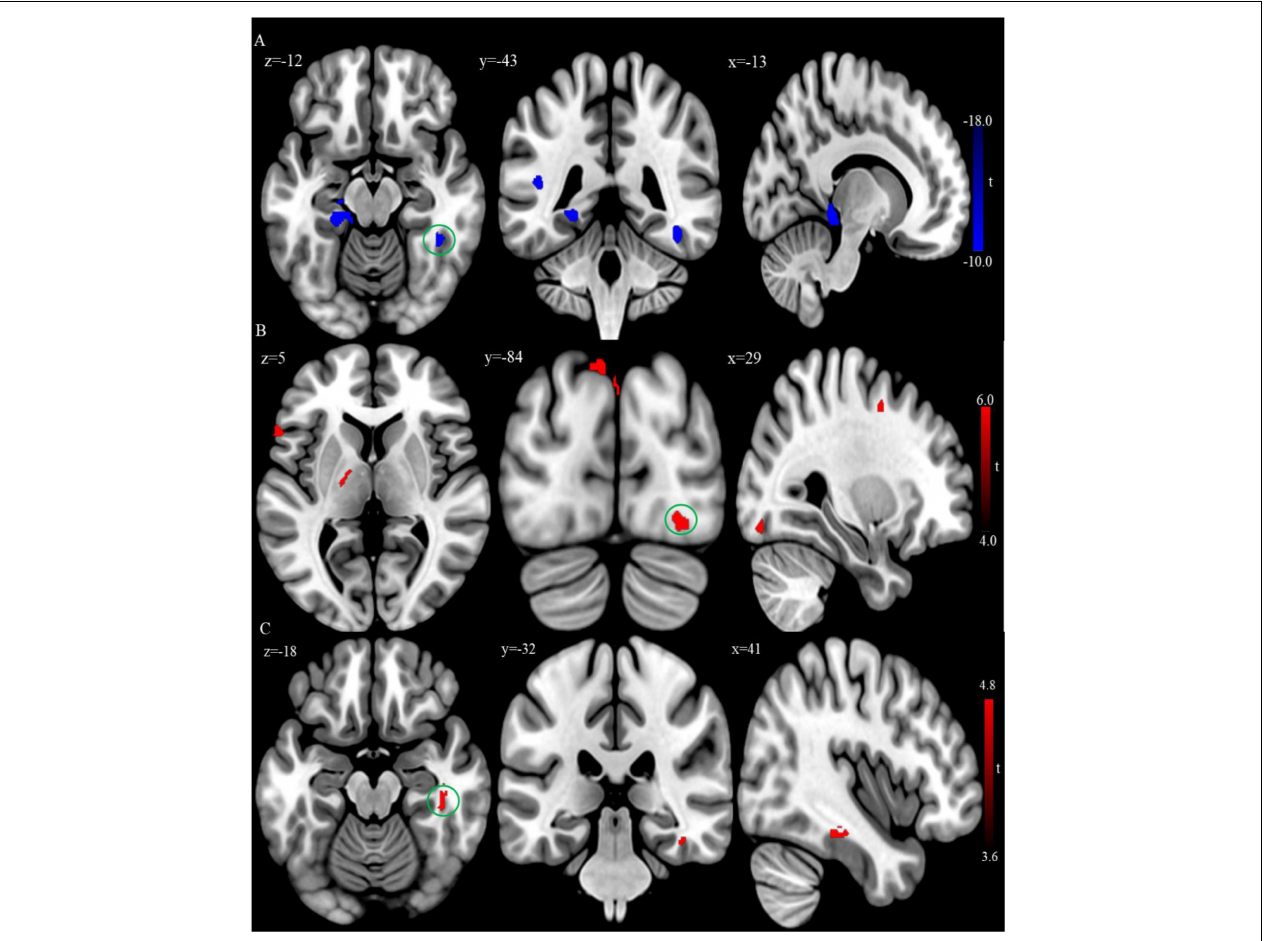
FIGURE 3 | (A) Brain regions showing significant differences of gray matter volume (GMV) between the patient group and healthy control group at baseline. (B) Brain regions showing significant difference of GMV between the posttreatment and baseline in the patient group. (C) Conjunction analysis maps of GMV differences [(baseline vs. controls) ∩ (posttreatment vs. baseline)]. The warm color denotes the region where the GMV is larger, and the cool color denotes the region where the GMV is smaller. The color circle denoted the overlapped region of GMV differences.